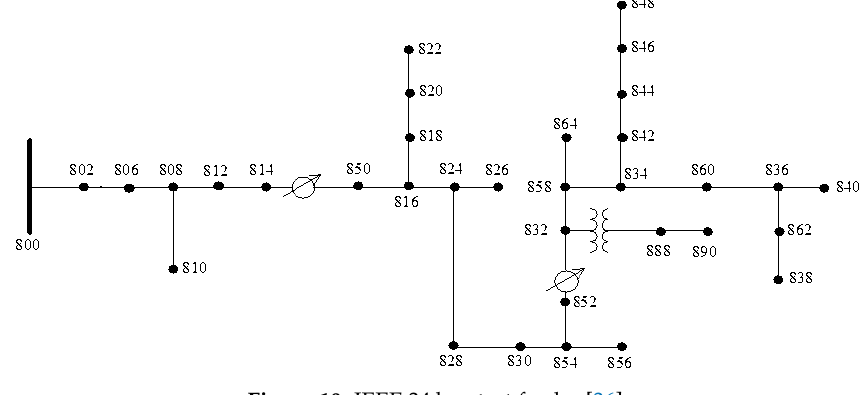
Figure 10. IEEE 34 bus test feeder